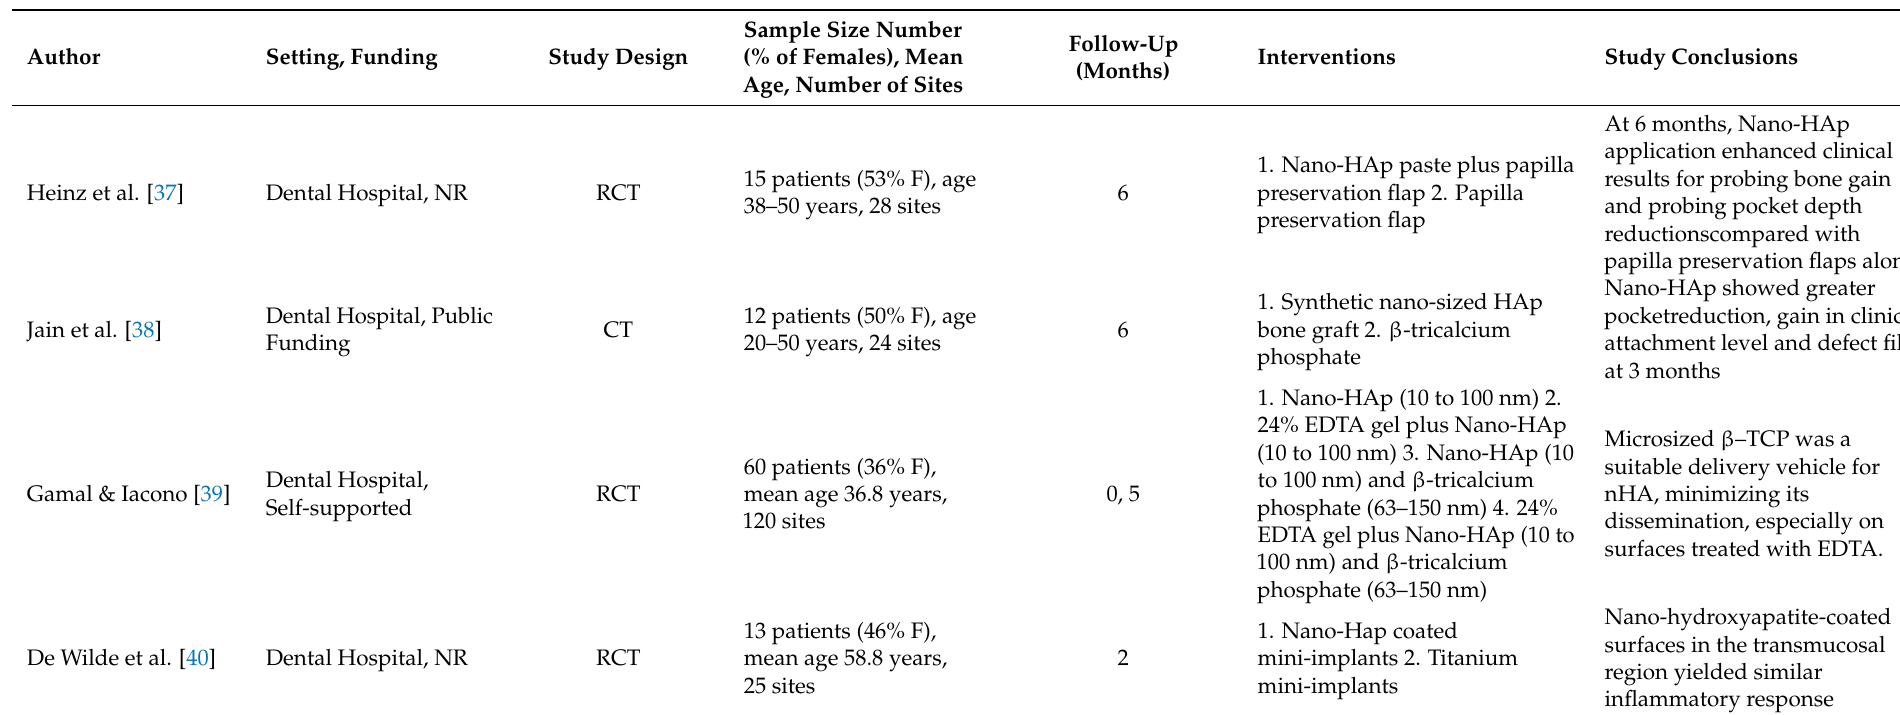
Table 5. Summary of Nano-HAp application in periodontology and